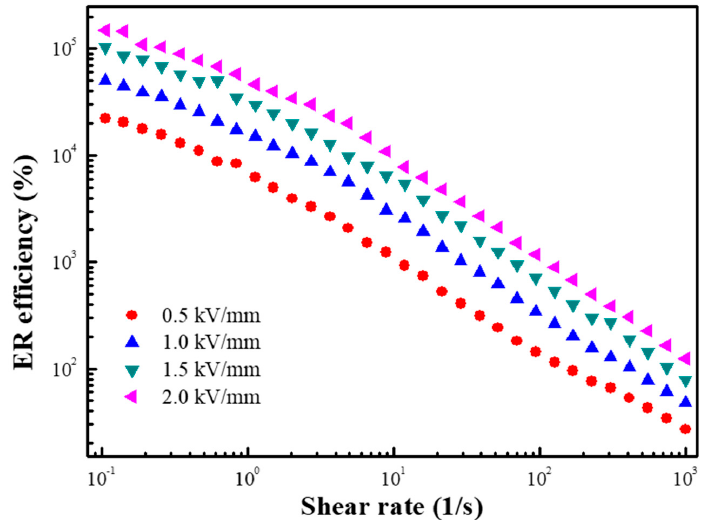
Figure 5. Shear rate-dependent ER efficiency of PDPA/Fe 3 O 4 -based ER fluid (10 vol%, 50 cSt silicone oil) under different electric field strengths.